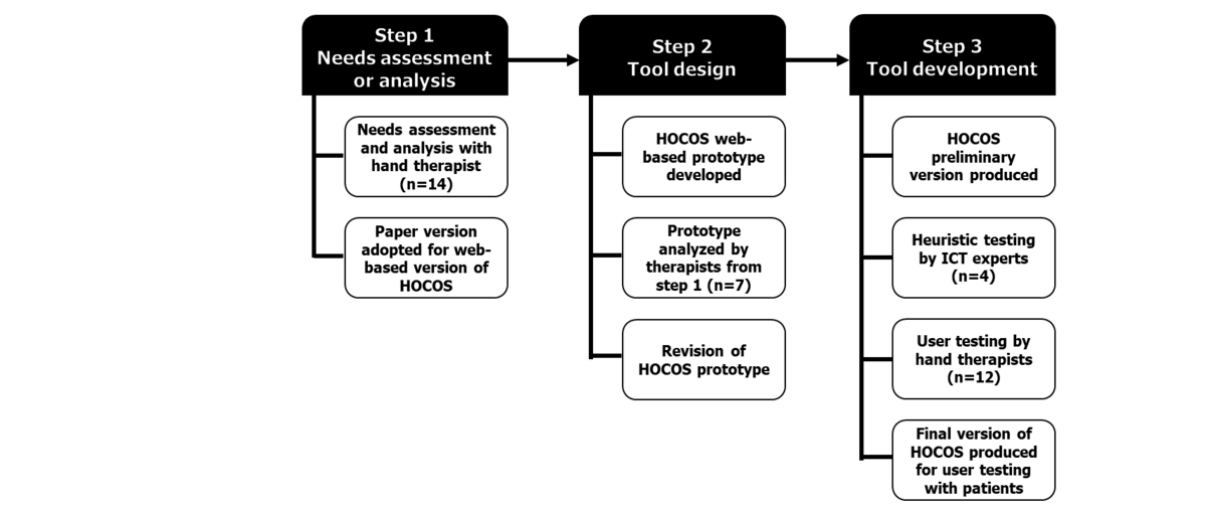
Figure 1. Diagram depicting the first 3 steps of Assessment or analysis, Design, Development, of the ADDIE Model. HOCOS: Hand Therapy Online Coping Skills; ICT: information and communications